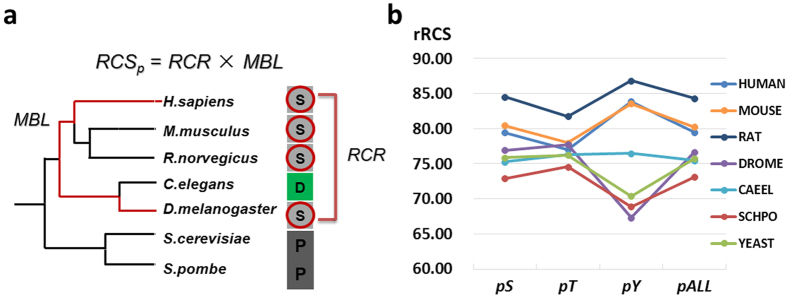
The evolutionary analysis of phosphorylation conservation.(a) As previously described43, RCSp was calculated as RCR*MBL. (b) We further calculated rRCS values for phosphorylation sites, and the average rRCS values of pS, pT, pY and all sites were shown for each species.